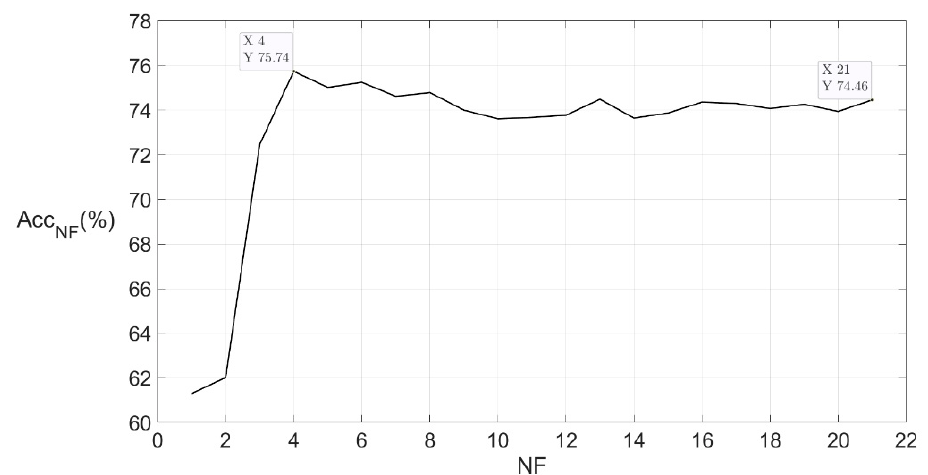
Figure 7. Relation between NF and Acc NF . NF is the number of feature types. After performing the random forest algorithm on a dataset of all features, a score for each feature type was provided. By adopting NF types of features with the highest score, we constructed a new dataset and performed a random forest on it, and the accuracy of the model was marked as Acc NF . The figure shows the trend of Acc NF change as the NF